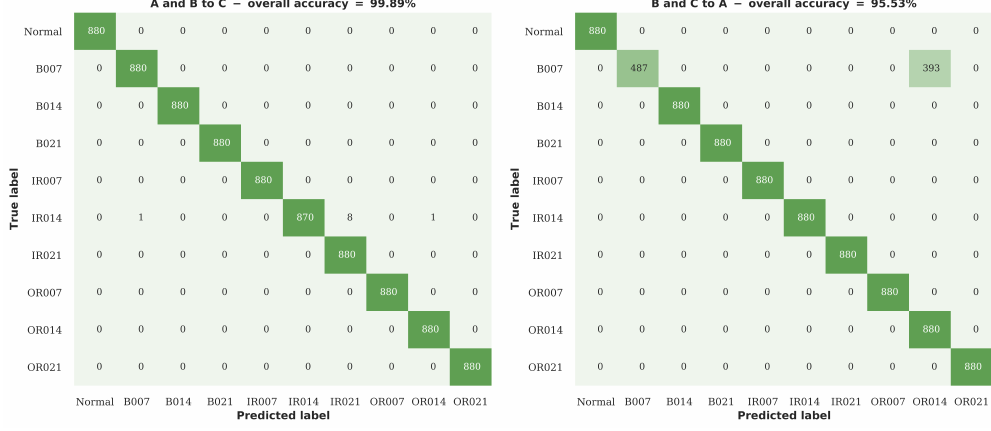
Figure 11. Confusion plots for the RNN-WDCNN model on the two of the domain adaptation cases considered in scenario